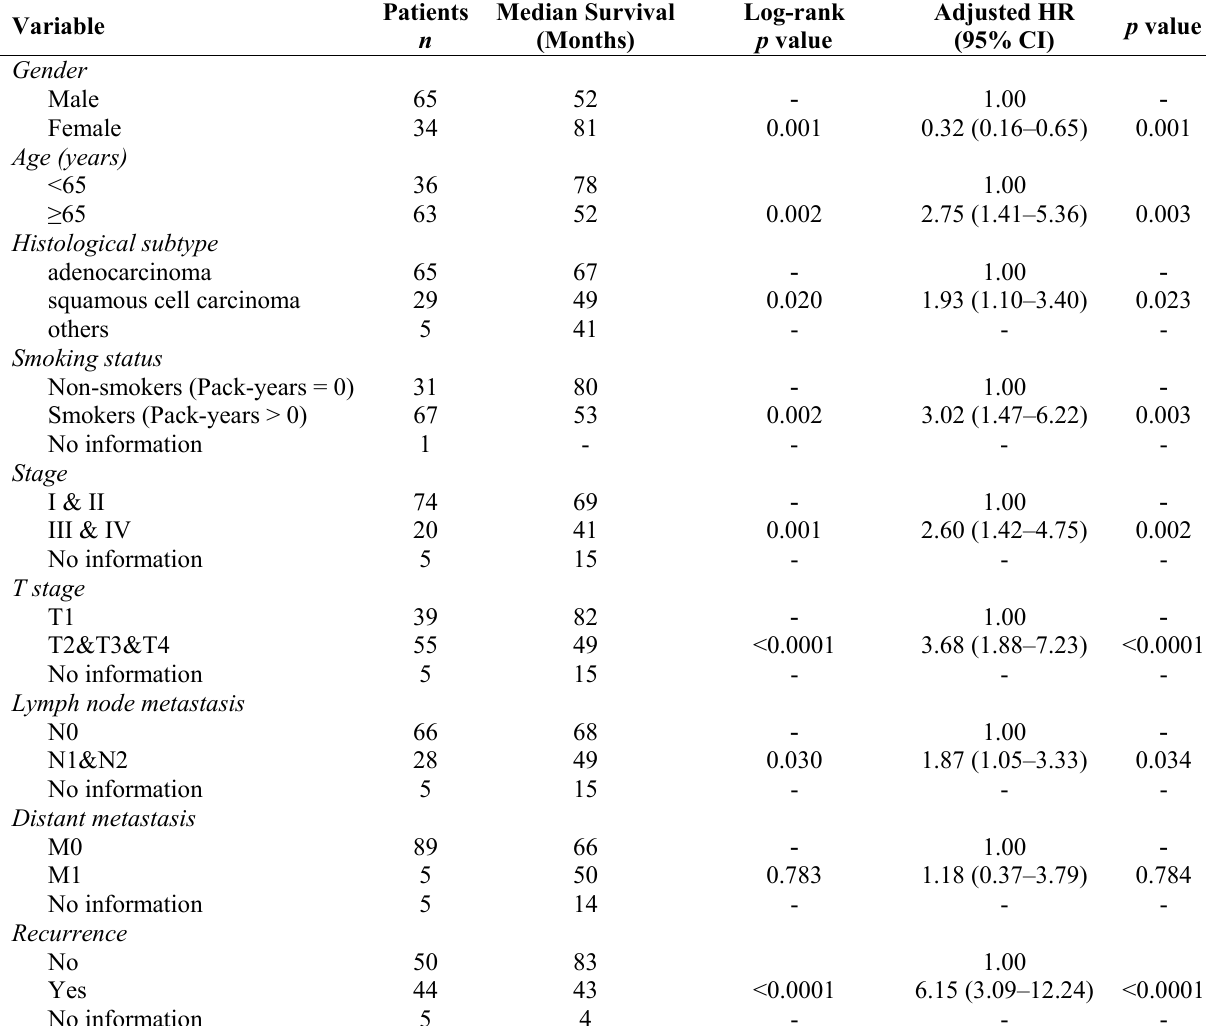
Table 1. Demographic and Clinical Characteristics of Lung Cancer